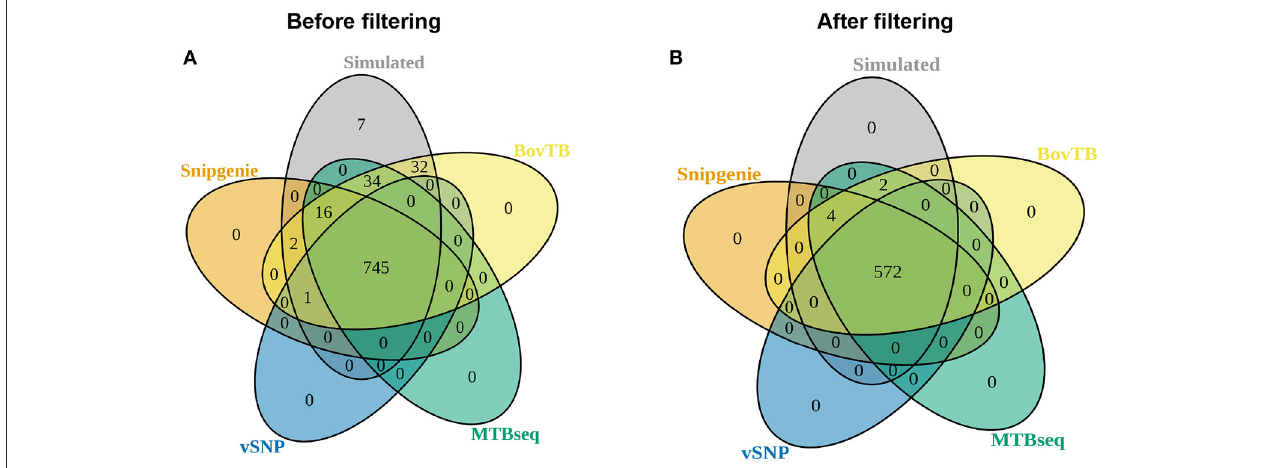
FIGURE 4 | Venn diagram showing the agreement between the positions identified by the different pipelines and the simulated dataset (A) before and (B) after hard filters (filter F) were